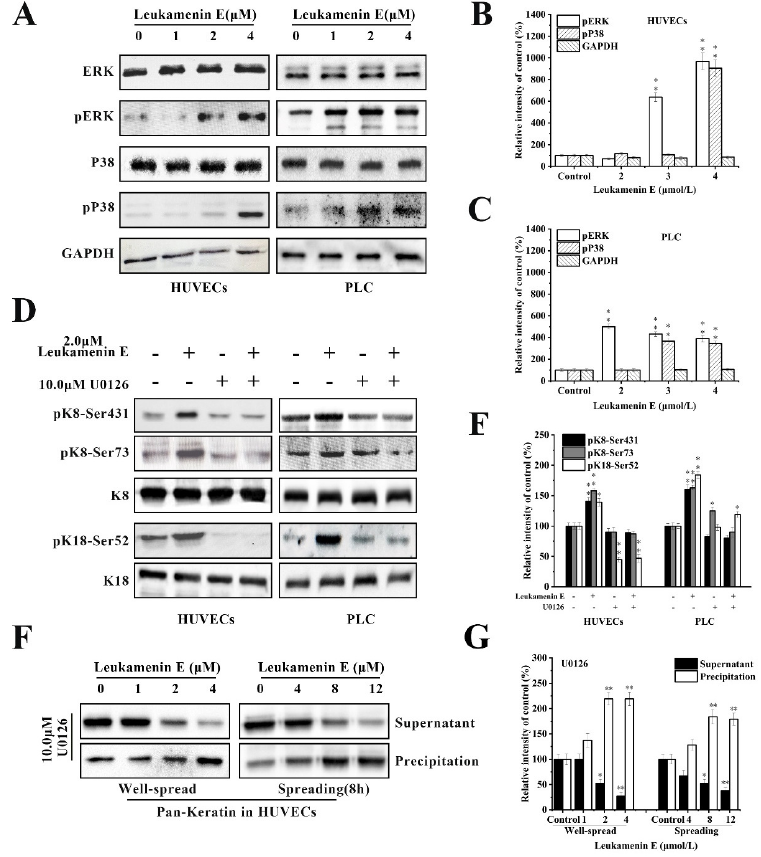
Figure 8. Extracellular signal-regulated kinases (ERK) mediates leukamenin E-induced K8/18 phosphorylation and increased keratin solubility in HUVECs and PLC. ( A – C ) Leukamenin E-induced activation of ERK and P38 phosphorylation in HUVECs and PLC and their quantitative analysis. ( D ) ERK mediates leukamenin E-induced K8/18 phosphorylation. HUVECs and PLC were treated with 10 μM U0126 for 1 h followed by incubation with 2.0 μM leukamenin E for 24 h. Western blotting was performed using pK8-Ser431, pK8-Ser73, and pK18-Ser52 antibody. ( E ) Graph depicts the quantification of keratin by grey level analysis. ( F ) ERK mediates leukamenin E-induced increase of keratin solubility. Well-spread HUVECs were treated with 10 μM U0126 for 1 h followed by incubation with 2.0 μM leukamenin E for 24 h or the spreading HUVECs were treated with 10 μM U0126 for 1 h followed by incubation with leukamenin E at the indicated concentrations for 8 h. WB was performed using Pan-K antibody. ( G ) Graph depicts the quantification of keratin by grey level analysis. The data shown represent the means ± standard deviation (S.D.) of three independent experiments. * p < 0.05, ** p <0.01, νersus the control